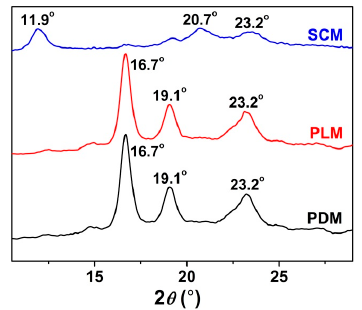
Figure 5. WAXD profiles of PDM, PLM, and SCM.